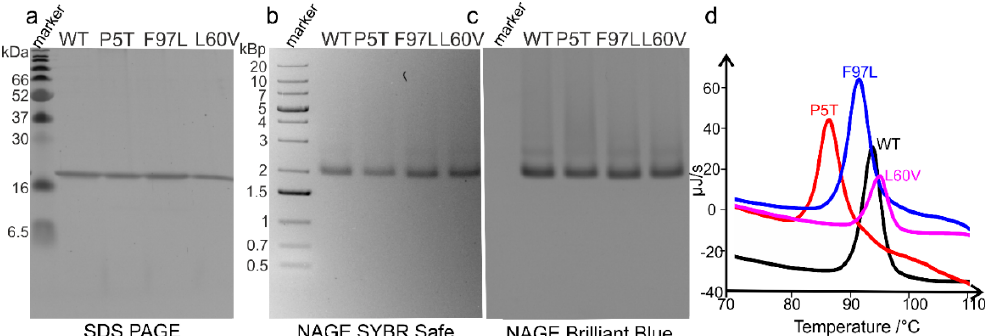
Figure 1. Purification and thermal stability of different HBc variants. ( a ) Purification products of recombinant WT-HBc (genotype D; strain ayw; GenBank: V01460.1.) and its mutants P5T-HBc, F97L-HBc and L60V-HBc were analyzed by 15% SDS–PAGE stained with Coomassie brilliant blue. For each construct, 3 µg protein was applied. The molecular weights of the protein standards in the first lane are indicated in kDa. The following lanes from left to right contain purified WT-HBc, P5T-HBc, F97L-HBc and L60V-HBc; ( b , c ) show native agarose gel electrophoresis (NAGE) of 7 µg of the same constructs as in ( a ) on a 1% agarose gel. The first lane shows the DNA-marker with the size of the DNA standards indicated in kilo base-pairs; ( b ) NAGE stained with SYBR Safe, which stains nucleic acids; ( c ) NAGE stained with Coomassie brilliant blue, which stains protein, but not nucleic acids. Electron micrographs of the corresponding negatively stained HBc variants are shown in Figure S1; ( d ) differential scanning calorimetry (DSC) of the four HBc variants. The plot shows the heat flux plotted over the temperature. The transition temperatures for the capsids of the four constructs are: T M (P5T-HBc) = 86.2 °C, T M (F97L-HBc) = 91.3 °C, T M (WT-HBc) = 93.7 °C and T M (L60V-HBc) = 94.9 °C.